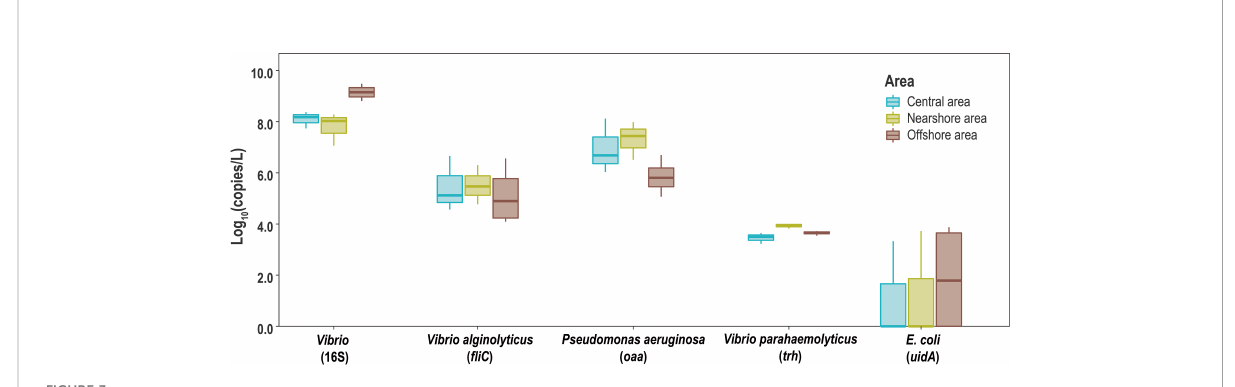
FIGURE 3 Boxplot of 16S rRNA gene of Vibrio and maker genes of V. alginolyticus, V. parahaemolyticus , P. aeruginosa , and E.